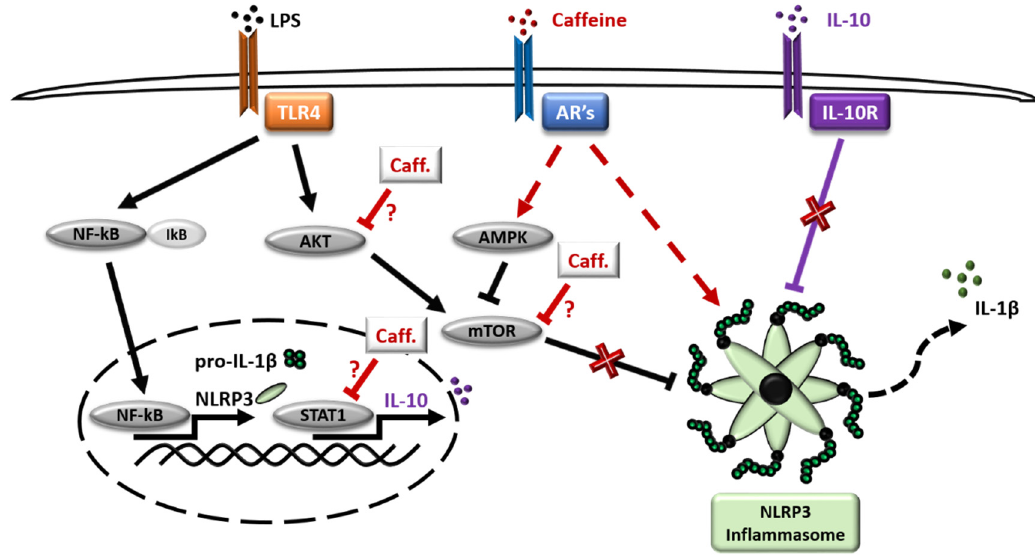
Figure 7. Schematic representation of caffeine effect on M-M Φ s subpopulation. Cells were pre-treated with caffeine (1 h) and then stimulated with LPS. Red color represents caffeine effects, dashed line represents indirect effects.